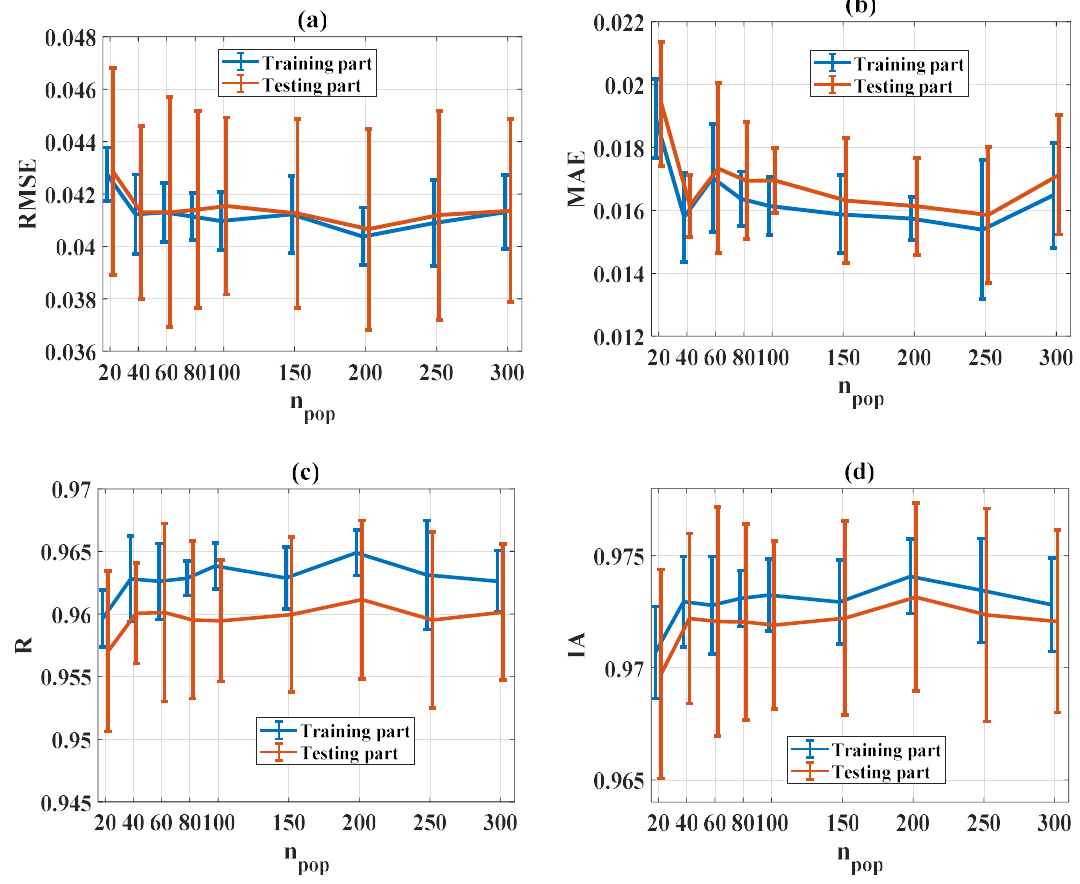
Figure 9. Evaluation of statistical criteria in the function of n pop : ( a ) RMSE, ( b ) MAE, ( c ) R, and ( d ) IA.